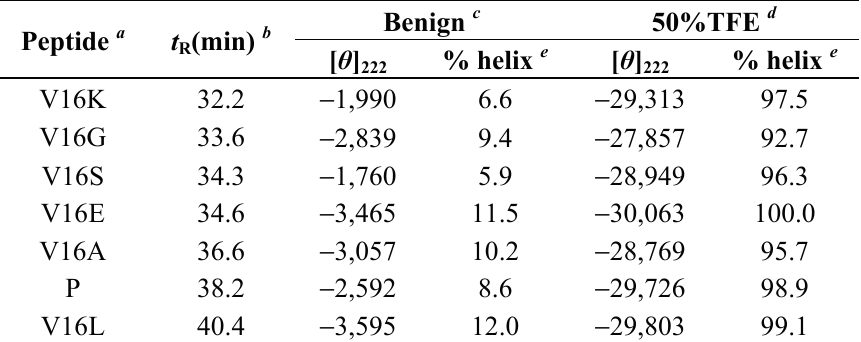
Table 2. Biophysical data of the peptide